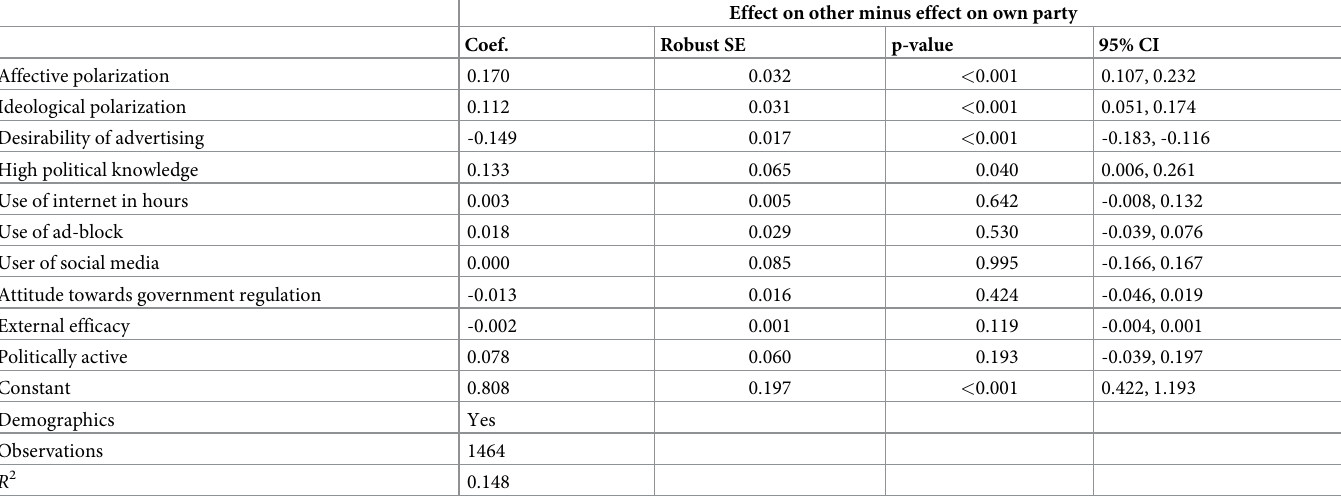
Table 1. Regression of determinants predicting the size of the difference between the perceived effect of online targeted political advertisement on the other party versus one’s own